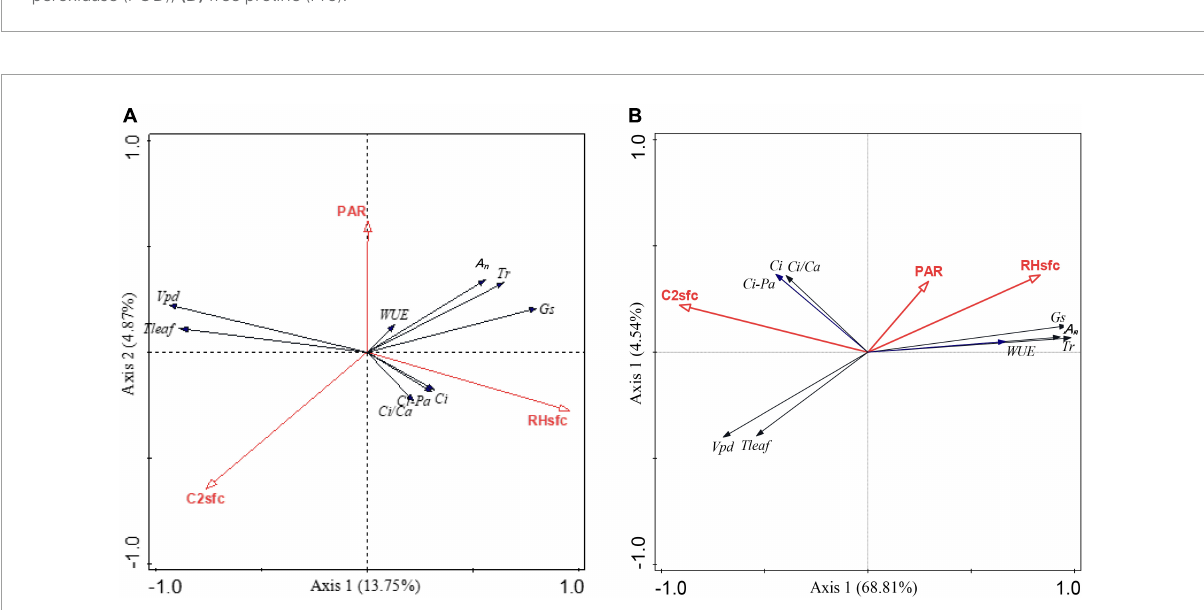
FIGURE4 Effects of microenvironment resources on leaf gas exchange based on redundancy analysis (RDA). (A) Cold spell impacted zone; (B) non-impacted zone. A n , leaf net photosynthesis rate; G s , stomatal conductance; C i , intercellular CO 2 concentration; T r , transpiration rate; V pd , vapor pressure deficit; T leaf , leaf temperature; C i /C a , the ratio of intercellular CO 2 concentration to air CO 2 concentration; C i -P a , intercellular CO 2 pressure; WUE, leaf water use efficiency; PAR, photosynthetically active radiation; RH sfc , relative air humidity; C2 sfc , air CO 2 concentration.